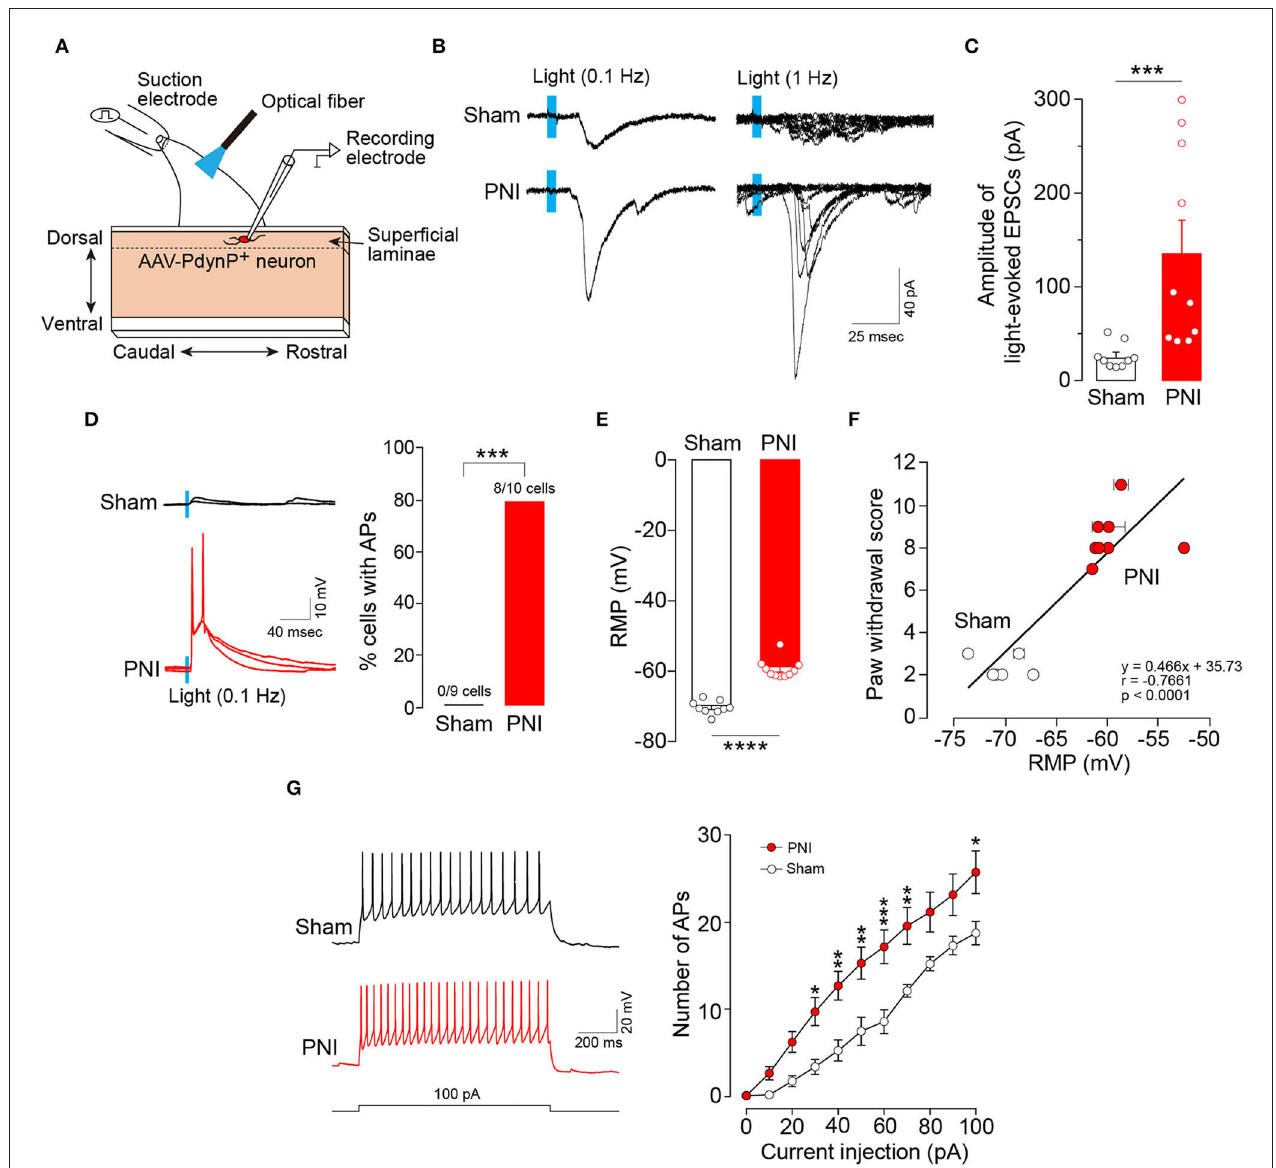
FIGURE 4 | Excitability of AAV-PdynP + neurons is enhanced after peripheral nerve injury (PNI). (A) Schematic diagram of whole-cell recording in AAV-PdynP + neurons using a sagittal spinal cord slice of the L4 dorsal root from W-TChR2V4 rat. (B) Representative traces of excitatory postsynaptic currents (EPSCs) evoked by blue light (0.1 and 1Hz) in AAV-PdynP + neurons in spinal cord slices of rats with sham operation and PNI. (C) Quantitative analysis of the amplitude of light-evoked EPSCs of AAV-PdynP + neurons in sham-operated and PNI rats ( n = 9 neurons tested from 6 W-TChR2V4 rats with sham operation, n = 10 neurons tested from 8 W-TChR2V4 rats with PNI). *** P < 0.001, Mann–Whitney U test. (D) Representative traces of action potentials (APs) evoked by light (blue) of AAV-PdynP + neurons. Percentage of AAV-PdynP + neurons with or without APs was quantified. *** P < 0.001, Fisher’s exact test. (E) Resting membrane potentials (RMPs: mV) of AAV-PdynP + neurons in slices from sham-operated and PNI rats. **** P < 0.0001, unpaired t test. (F) Correlation plot showing the relationship between paw withdrawal score and RMPs of AAV-PdynP + neurons in rats with sham operation and PNI ( n = 6 W-TChR2V4 rats with sham operation, n = 8 W-TChR2V4 rats with PNI). Note that we recorded one neuron from one spinal cord slice from each animal in most cases, but in some cases, two or more neurons were recorded. Thus, some data were depicted with error bars. (G) Representative trace of APs evoked by injecting depolarizing currents (100pA, 1s) into AAV-PdynP + neurons in spinal cord slices of rats with sham operation and PNI. The relationship between firing frequency and injected current of AAV-PdynP + neurons ( n = 9 neurons tested from 6 W-TChR2V4 rats with sham operation, n = 10 neurons tested from 8 W-TChR2V4 rats with PNI). * P < 0.05, ** P < 0.01, and *** P < 0.001 vs. sham, two-way repeated measures ANOVA with post-hoc Bonferroni multiple comparison test. Data shown as mean ± SEM.